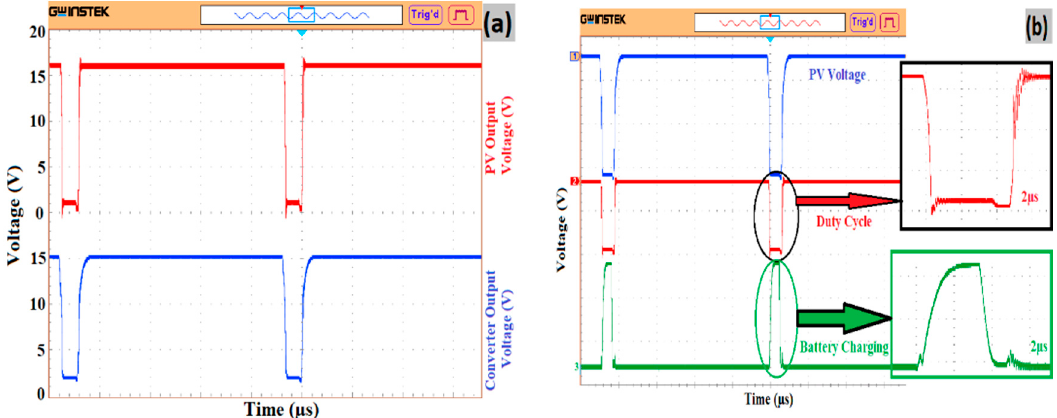
Figure 12. ( a ) The output waveform of the buck–boost converter from the oscilloscope, ( b ) output plot from the oscilloscope.